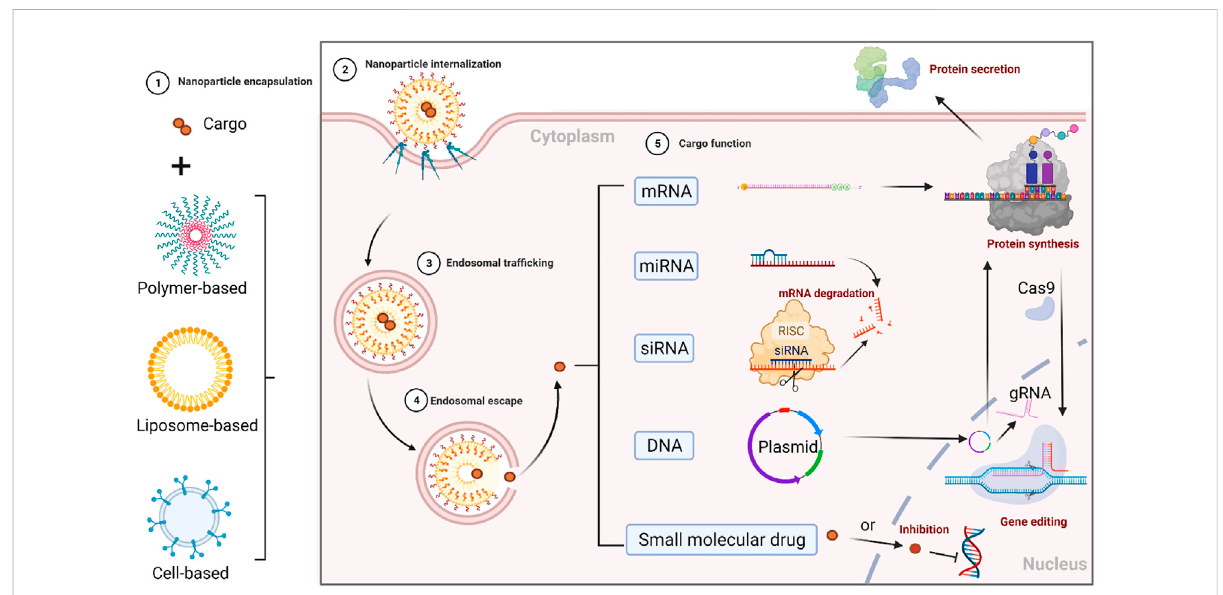
FIGURE 1 Delivery routeand mechanism of gene regulations. 1)nucleicacids (cargo) are encapsulated in nanocarriers for extracellular traf fi cking, 2) after crossing the cell membrane, nanoparticles (NPs) are cellular internalized and uptake into the endosome, 3) NPs ’ endosomal traf fi cking, 4) NPs ’ endosomal escape into the cytoplasm, 5) nucleic acids ’ separation from nanocarriers, and their functions at the target sites. Their functions vary but are not limited to: a) protein translation (mRNA in ribosome is decoded into thepolypeptideor a protein); b) gene regulation (miRNA and siRNA couldregulatespeci fi cgeneexpressions);c)genetranscription(pDNAinthenucleusisactivelytranscribedintomRNAandtranslatedintotheprotein itencodesfor via thesameproteinexpressionmachinerythecellusesto producetheproteinthatitneedsto functioncorrectly.Forinstance,during the gene editing process in the CRISPR-Cas9 system, a short guide RNA (gRNA) sequence in this two-component complexed system guides the Cas9endonucleaseto thetargetsite.TheCas9 endonuclease canbetranscriptedand translated frompDNAorbedirectly translatedfrommRNA.In addition, small molecular drugs such as transcription or translation inhibitors could also effectively inhibit gene